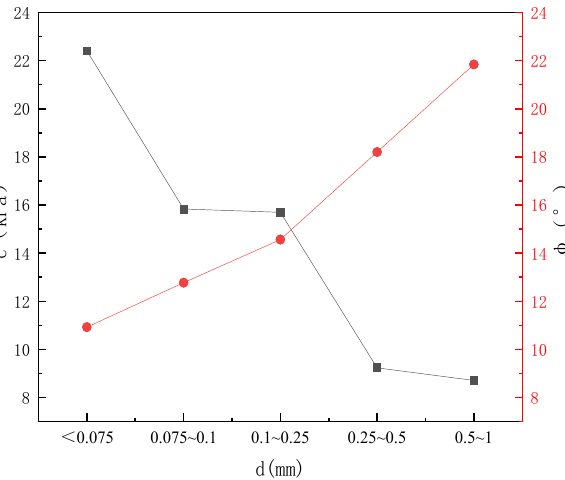
Figure 12. Plot of cohesion and internal friction angle and particle size.